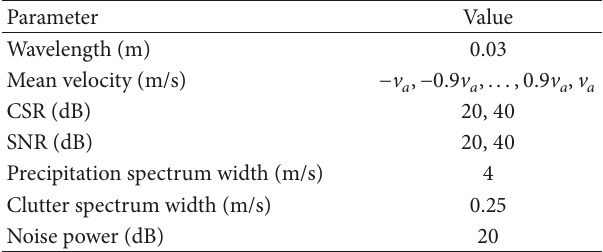
Table 1: Parameters of the simulated radar signal.